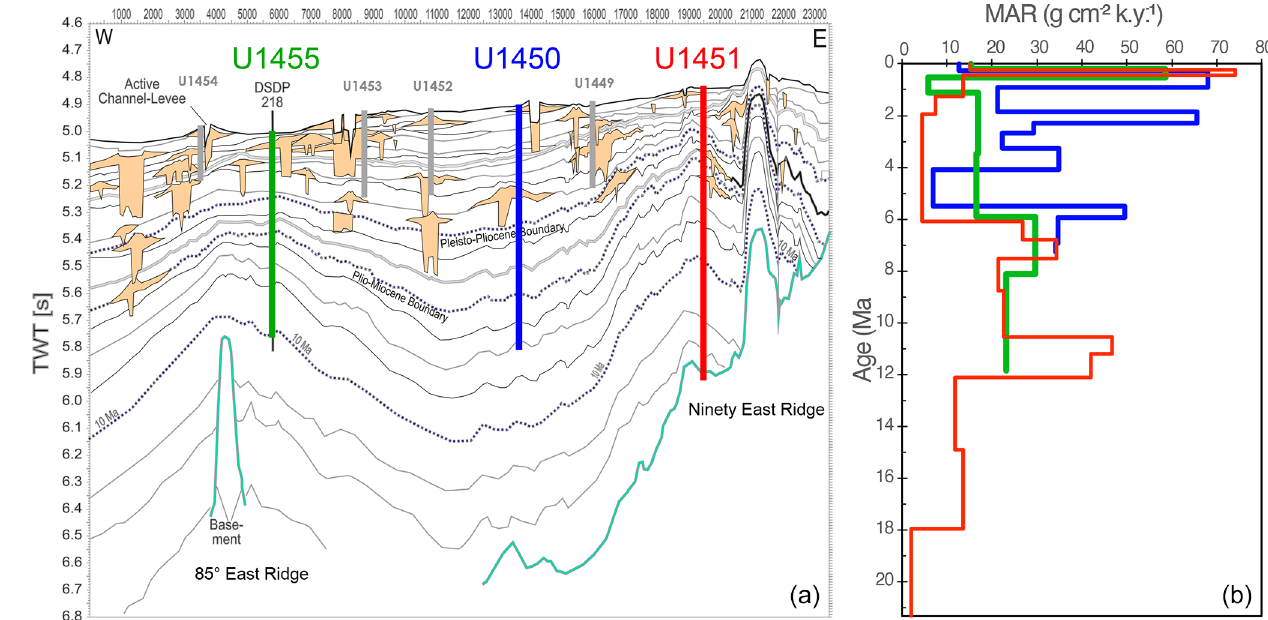
Figure 5. (a) Interpreted seismic section of the Bengal fan at 8 ◦ N (Schwenk and Spieß, 2009) with position of the Expedition 354 sites. The upper fan comprises a stacking of channel levee systems, with alternations of high accumulation of fan deposits and hemipelagic intervals that are 2 orders of magnitude lower. The easternmost Site U1451 drilled ∼ 1200m on the west flank of the 90 ◦ E Ridge, where the onset of turbiditic deposition at this position has been dated around 18Ma. Two other 900m penetration sites (U1550 and U1455) complete the Neogene record. (b) Mass accumulation rates for the three deep records of Expedition 354. Age models are from France-Lanord et al. (2016), Lenard et al. (2020a), Cruz et al. (2021), and Reilly et al.